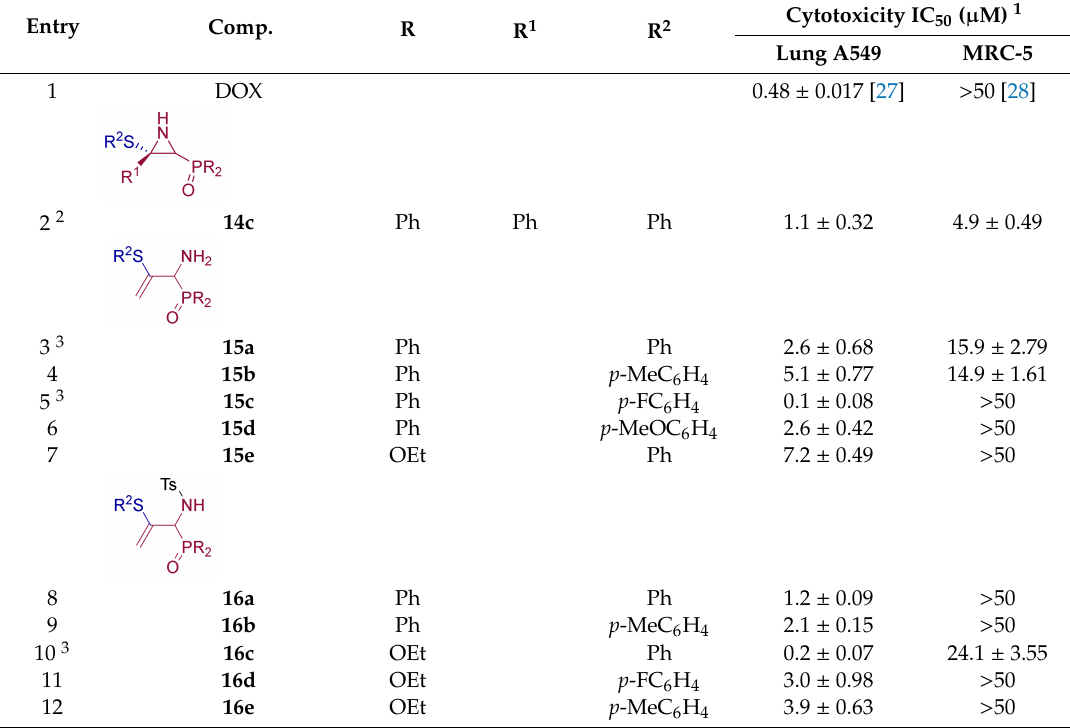
Table 5. Antiproliferative activity of synthesized compounds obtained from the addition of thiophenols to 2 H -azirines 1